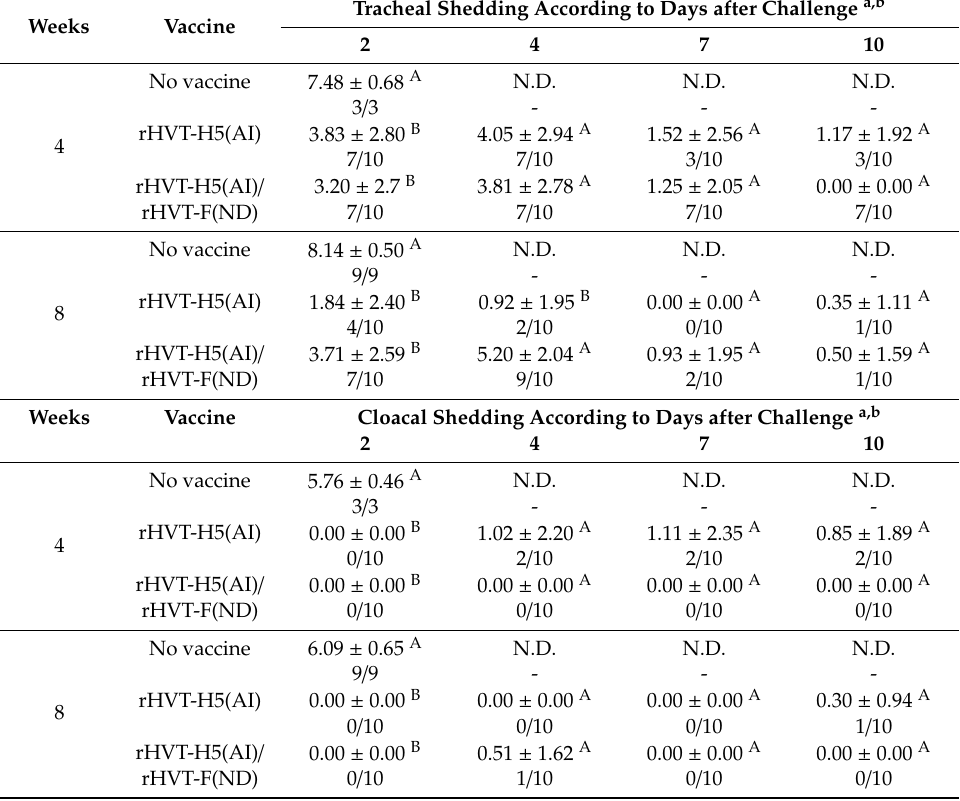
Table 5. Tracheal and cloacal shedding of HPAIV after challenges at 4 and 8 weeks of age with H5-HPAIV administered to SPF WL chickens (experiment I) vaccinated at day-old with rHVT-F(ND), rHVT-H5(AI), or both vaccines.